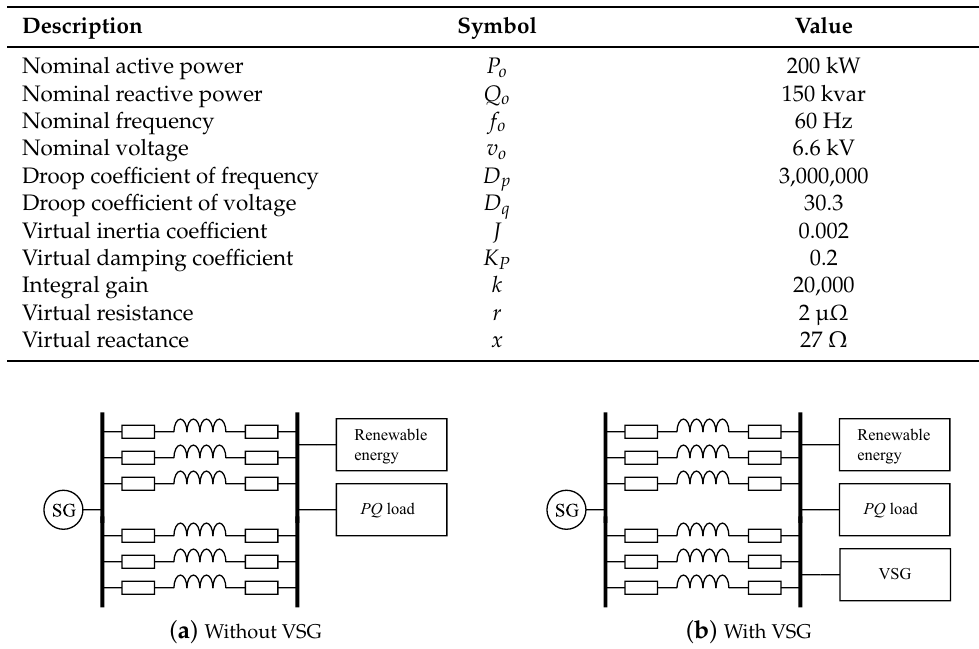
Table 2. VSG parameters.